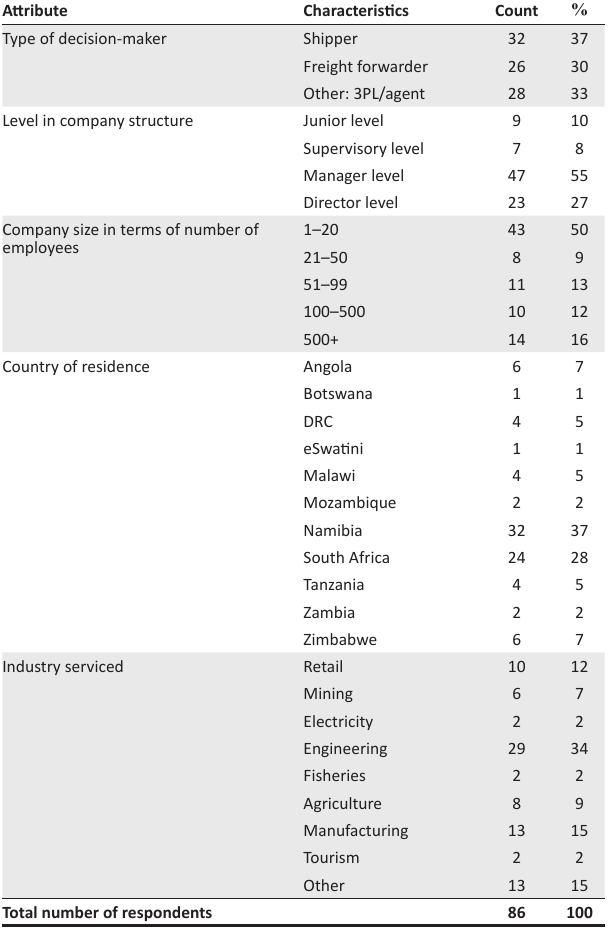
TABLE 2: Sample statistics. Attribute